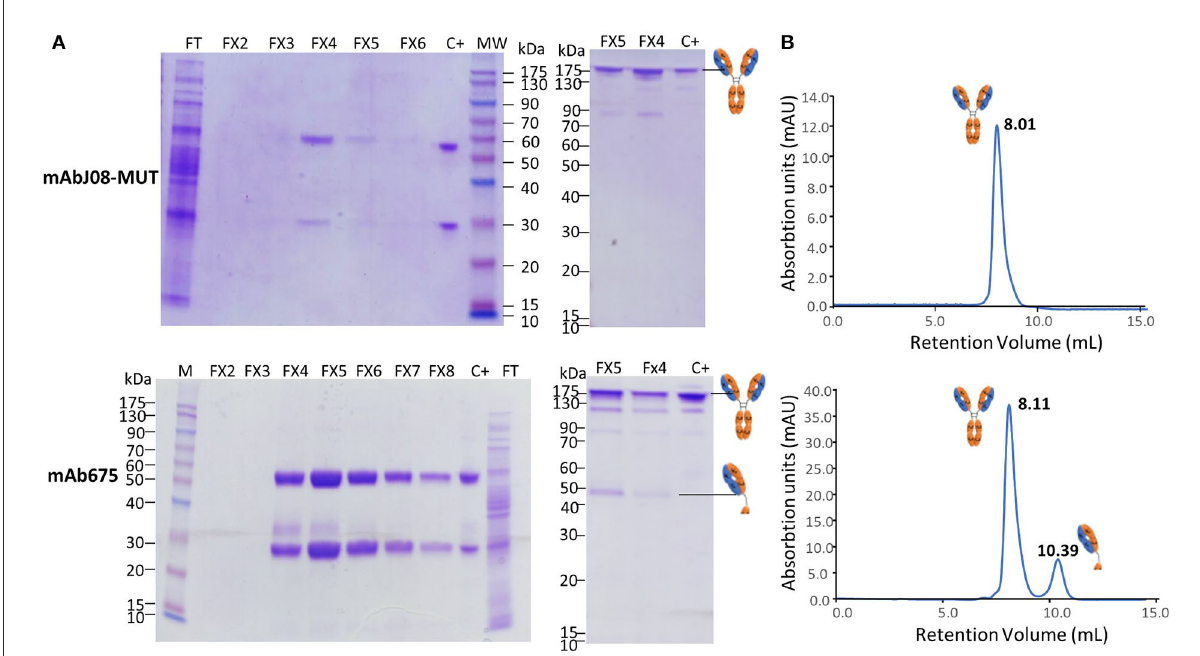
FIGURE4 Purification and characterization of the plant-derived antibodies. AntiSARS-CoV-2 nAbs were purified by protein-A affinity chromatography and eluted fractions (FX-10 µ L per lane) were separated by 12% SDS-PAGE under reducing (left side) and non-reducing conditions (right side), followed by Coomassie blue staining (A) . FT: flow-through of protein-A column; C + : purified human IgG1 mAbRTX used as a reference (2 µ g). (B) Size-exclusion chromatography was performed on a Superdex TM 75 10/300 GL column, as described in the Section Materials and methods. The retention volumes (mL) of the peaks obtained and the schematic representation of the molecules contained in the eluted peaks are